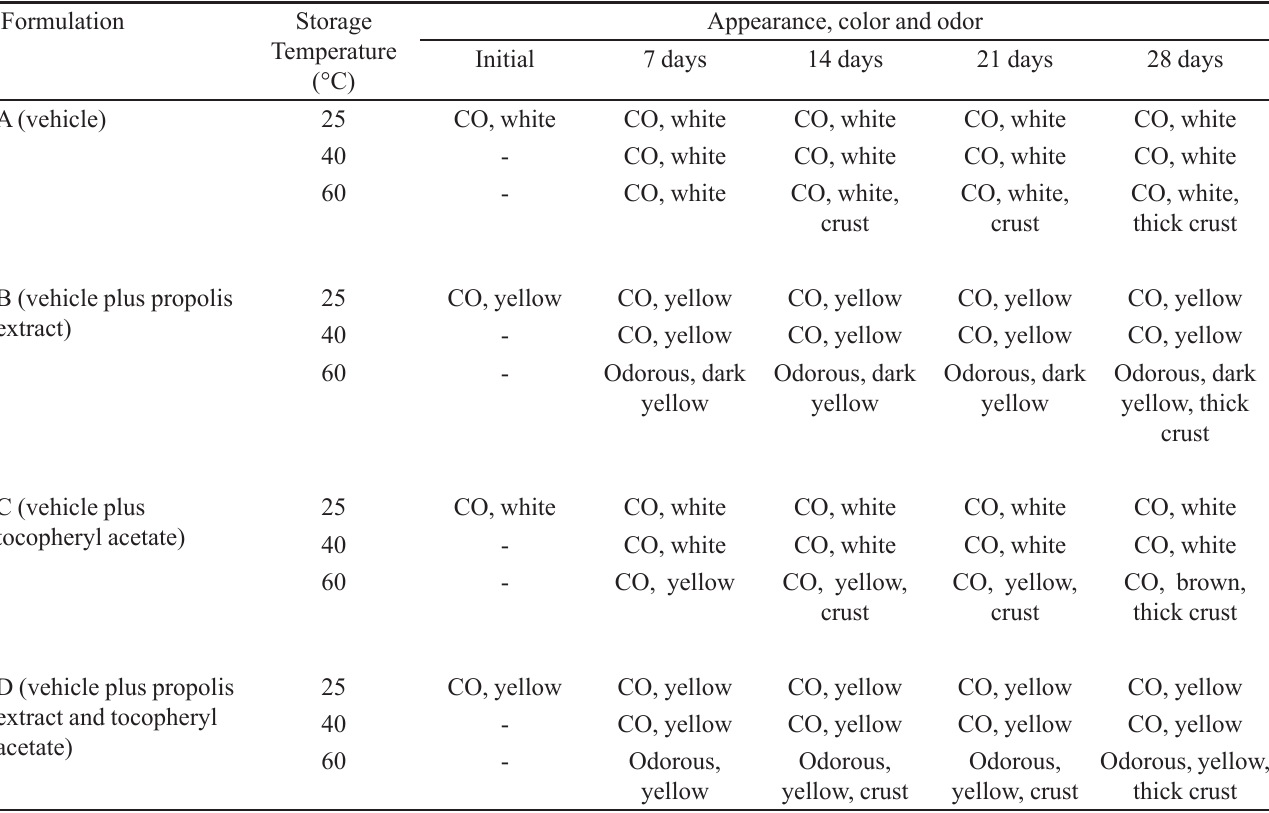
4,404,504,604,704,804,905,005,105,205,305,405,50 FIGURE 1 - pH of formulations (baseline and after a 28-day period) at room temperature, 40 °C and 60 °C (A: vehicle; B: vehicle plus propolis extract; C: vehicle plus tocopheryl acetate; D: vehicle plus propolis extract and tocopheryl acetate). TABLE I - Appearance, color and odor of formulations over a 28-day period at room temperature (25 °C), 40 °C and 60 °C Formulation